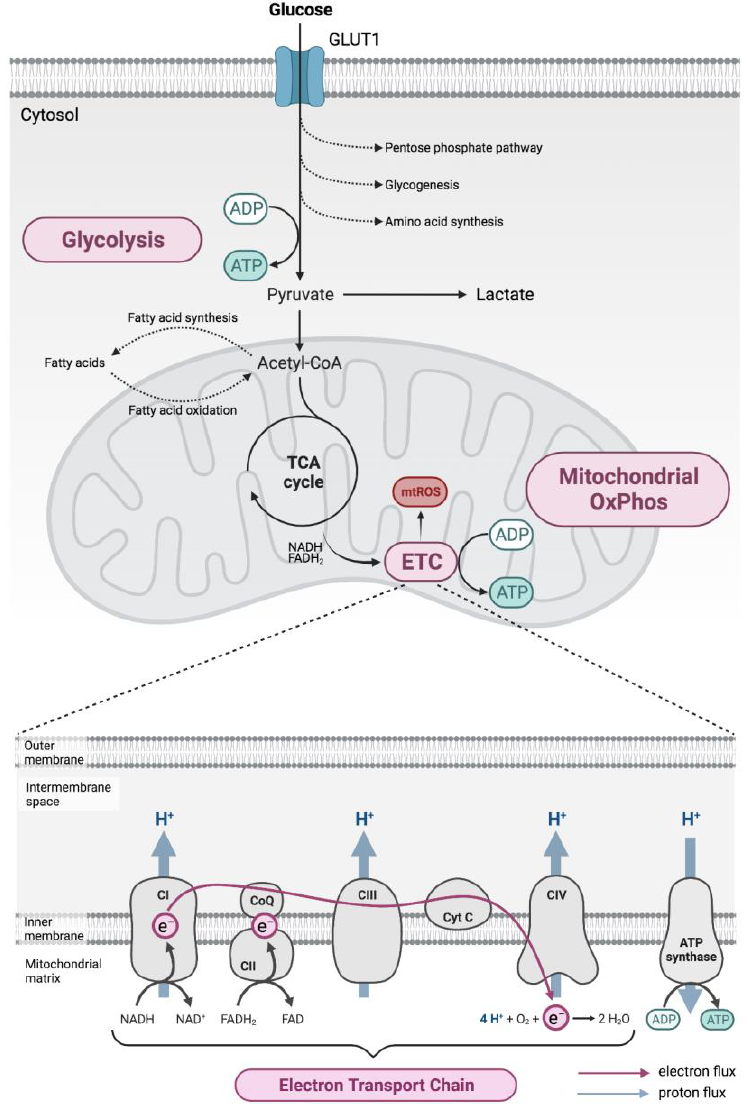
Figure 1. Cellular metabolism. Energy production principally involves glucose metabolism via gly- colysis, which is closely coupled to the mitochondrial respiratory chain, which is located at the inner mitochondrial membrane and consists of electron transport chain (ETC) complexes I (CI), II (CII), III (CIII) and IV (CIV), as well as ATP synthase (complex V, CV). Energy released during electron (e − ) transport along the ETC (pink arrow) allows protons (H + ) to be moved to the intermembrane space (blue arrows), generating an electrochemical gradient that is used by complex V to synthesise ATP. ADP: adenosine diphosphate; ATP: adenosine triphosphate; e − : electron; FAD + : flavin adenine dinucleotide; FADH 2 : dihydroflavin adenine dinucleotide; H + : proton; H 2 O: water; NAD + : nicotinamide adenine dinucleotide; NADH: dihydronicotinamide adenine dinucleotide; O 2 : oxygen; OxPhos, oxidative phosphorylation; Pi: inorganic phosphate; TCA, tricarboxylic acid.